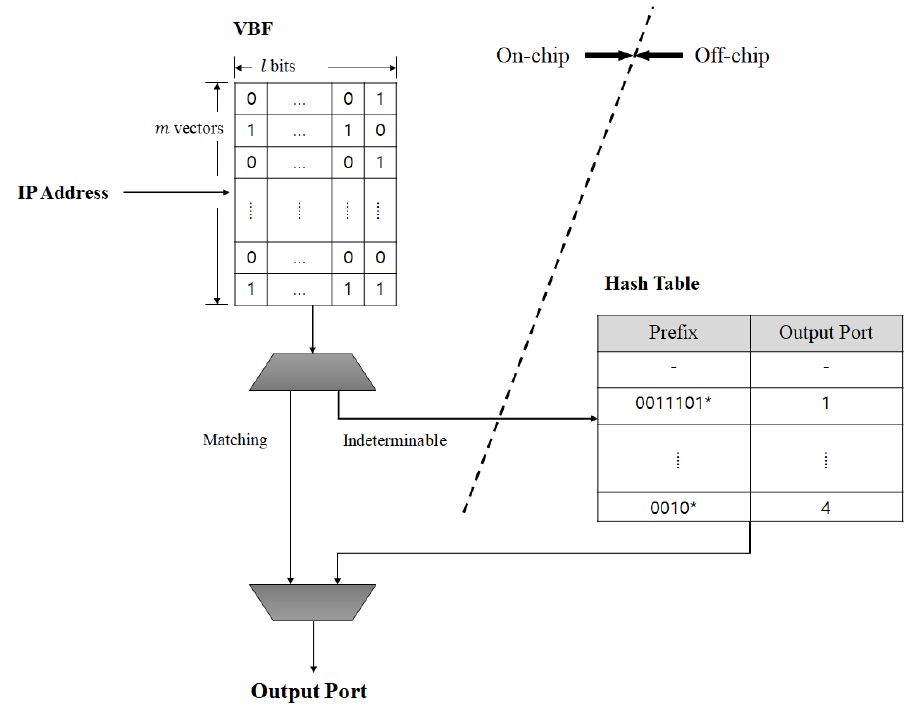
Figure 1. Overall structure of vectored Bloom filter (VBF)